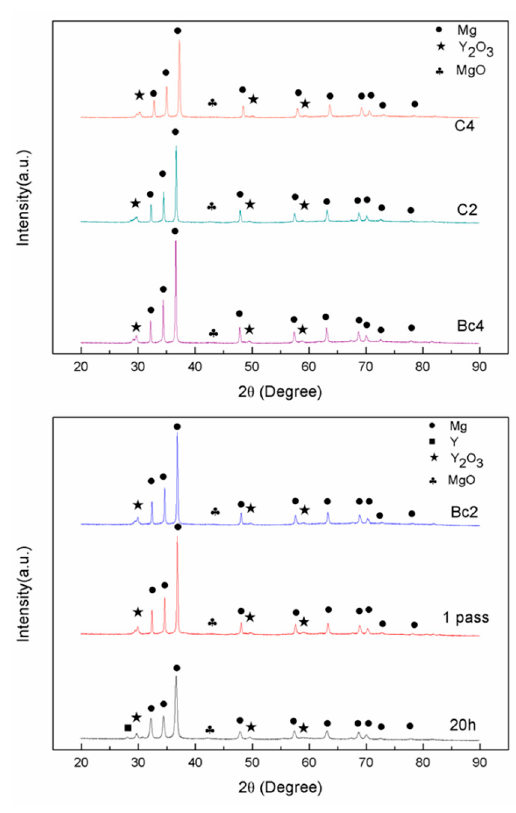
Figure 4. XRD patterns of powder after compacting by ECAP route C and Bc for one, two and four pass. The pattern of the 20-h-milled sample is also included for comparison.